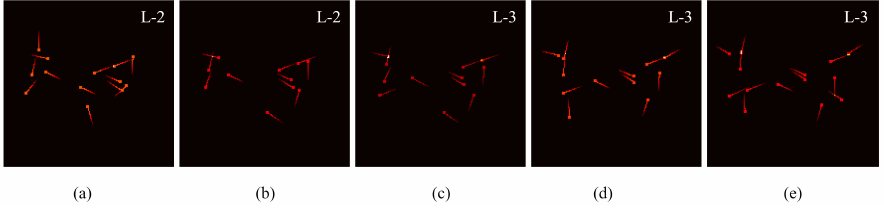
Figure 1. Illustration of single channel air traffic images. Five consecutive images from two classes. Among them, ( a , b ) are the same class, ( c – e ) are the same